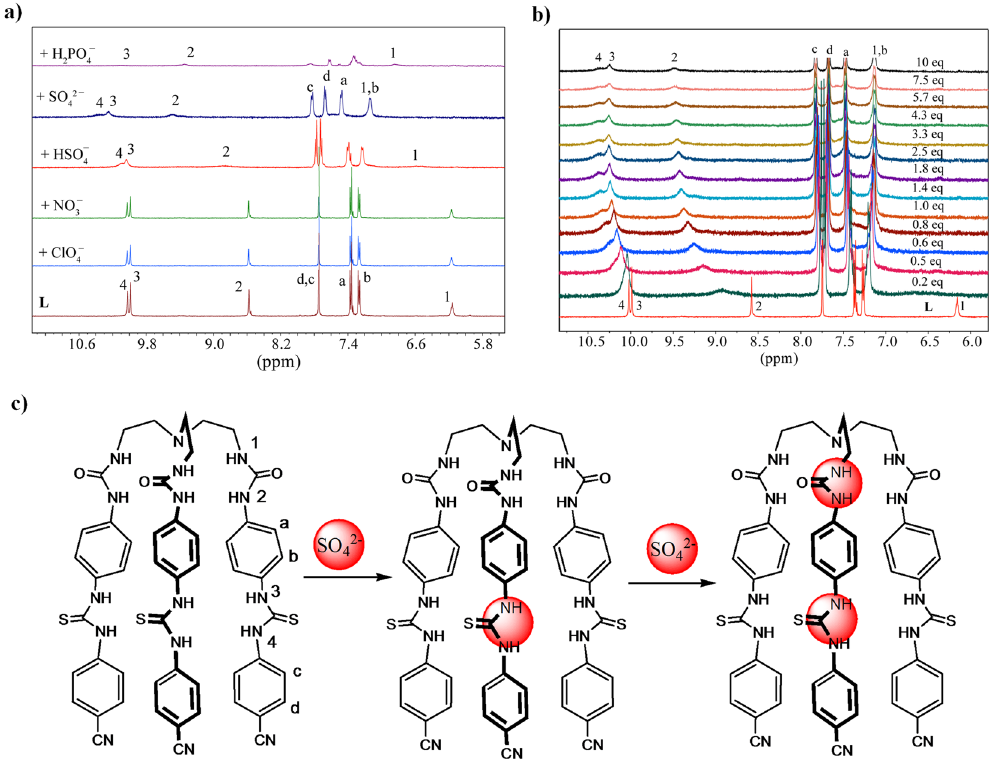
Figure 2. ( a ) Partial 1 H NMR spectra of L (2 mM) in the presence of 5 equivalents of different anions in DMSO- d 6 ; ( b ) partial 1 HNMR titration of L showing changes in the NH chemical shifts of L (2 mM) with an increasing amount of SO 42 − (20 mM) in DMSO- d 6 . (H1 = CH 2 N H CO, H2 = CON H Ar, H3 = ArN H CS, H4 = CSN H Ar); and ( c ) proposed binding mechanism of L with SO 42 − .